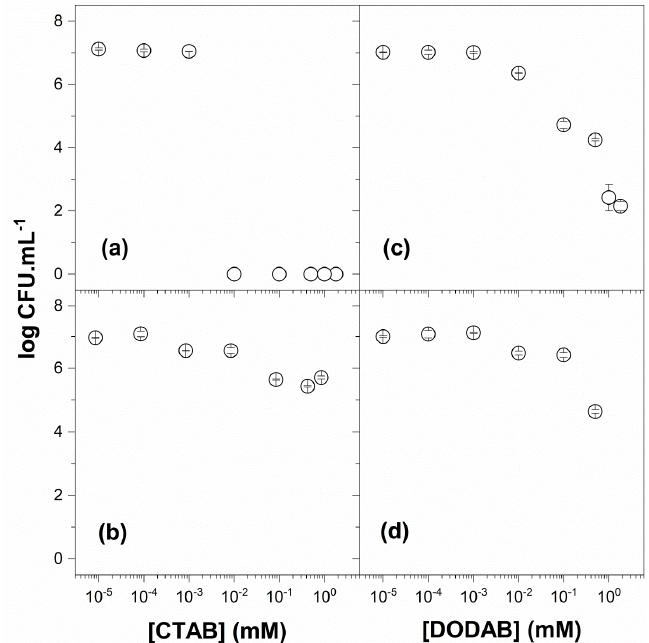
Figure 7. Viability of Candida albicans in the presence of CTAB (a), PMMA/CTAB (b), DODAB (c), and PMMA/DODAB dispersions (d). The NP dispersions of PMMA/CTAB and PMMA/DODAB were used after dialysis. The counting of colony-forming unities (CFU) was expressed in a logarithmic scale. The superior activity of QACs by themselves as compared to QACs in NPs is depicted from comparisons between (a) and (b) or (c) and (d). CTAB was active as a monomer at submicellar concentrations (a). DODAB was active as bilayer fragments (b).